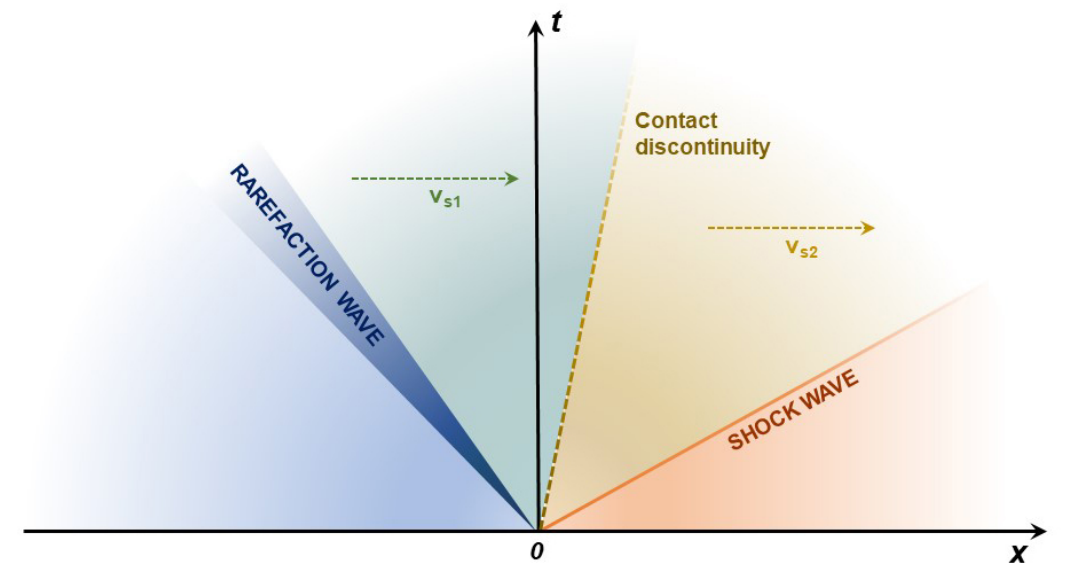
Figure 1. Propagation of shock, contact discontinuity and rarefaction waves for P L > P R